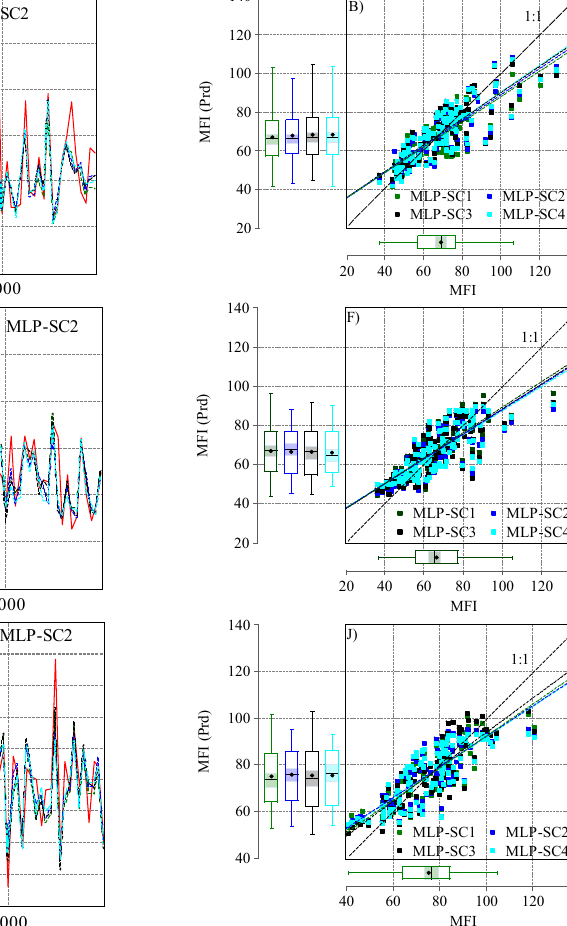
Figure 5. Observed and predicted MFI values when using the ANN–MLP algorithm in the studied station under four scenarios (SC1, SC2, SC3, and SC4): ( A ) evolution of observed and predicted MFI s in Budapest (1901–2020); ( B ) scatter plot of MFI observed vs. MFI predicted in Budapest; ( E ) evolution of observed and predicted MFI s in Debrecen (1901–2020); ( F ) scatter plot of MFI observed vs. MFI predicted in Debrecen; ( I ) evolution of observed and predicted MFI in Pecs (1901–2020); ( J ) scatter plot of MFI observed vs. MFI predicted in